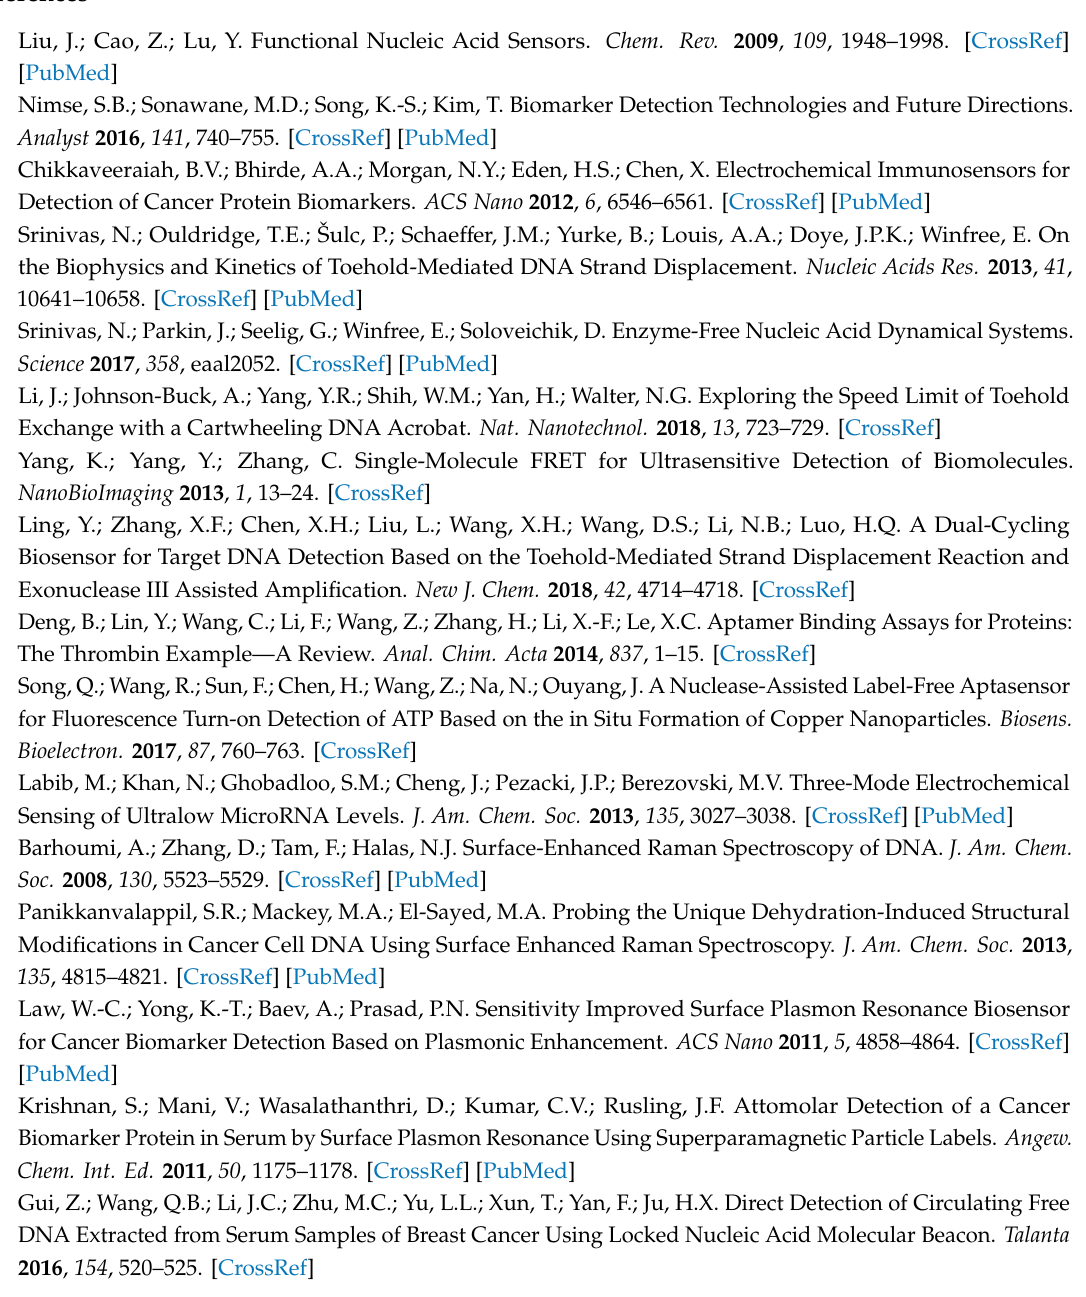
Table S1: DNA sequences, Table S2: Thermal annealing program, Figure S1: E ff ect of Mg 2 + concentration on sensor performance, Figure S2: Typical single-molecule traces, Figure S3: Single-molecule analysis of sensor-III with an alternative way of target